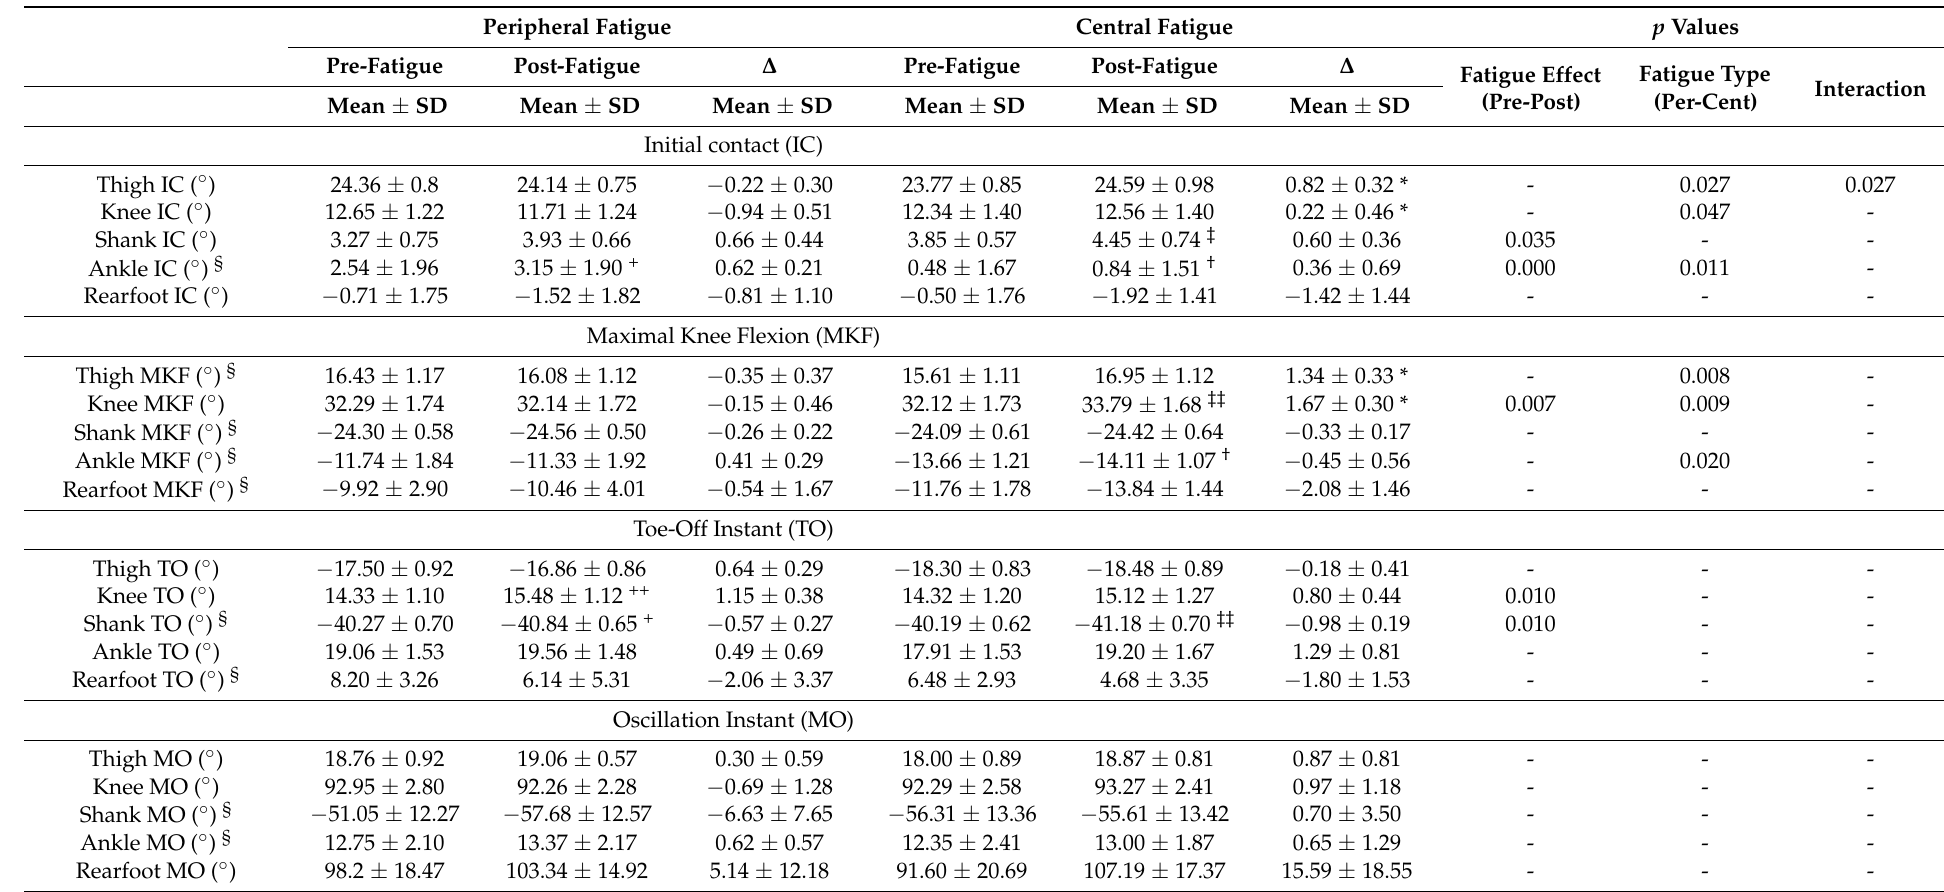
Table 1. Results of angular kinematics pre- and